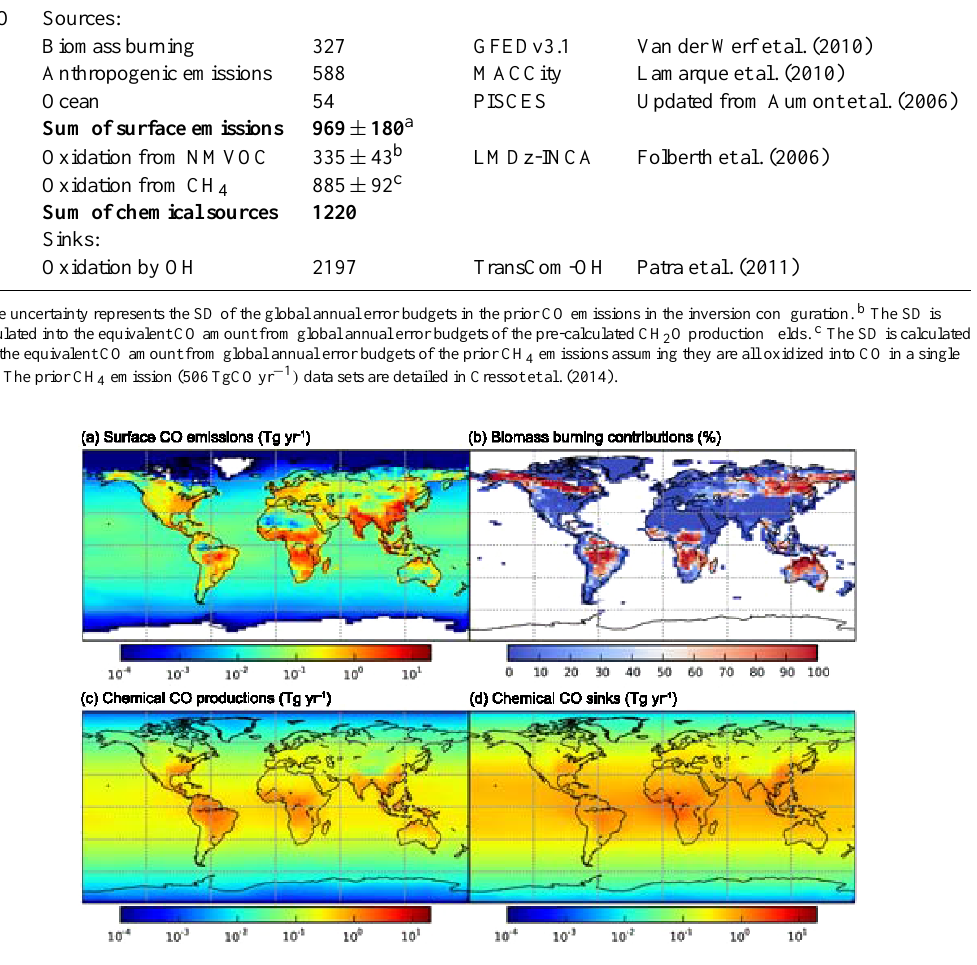
Figure 2. Distribution of prior budget terms for CO. Annual mean values per each model grid (2.5 latitude × 3.75 longitude) from 2002 to 2011 are shown. (a) Surface CO emissions, (b) relative percentages of CO emissions from biomass burning over land, (c) atmospheric CO productions from CH 4 and NMVOC, and (d) atmospheric CO chemical sinks. The chemical productions and sinks are calculated with